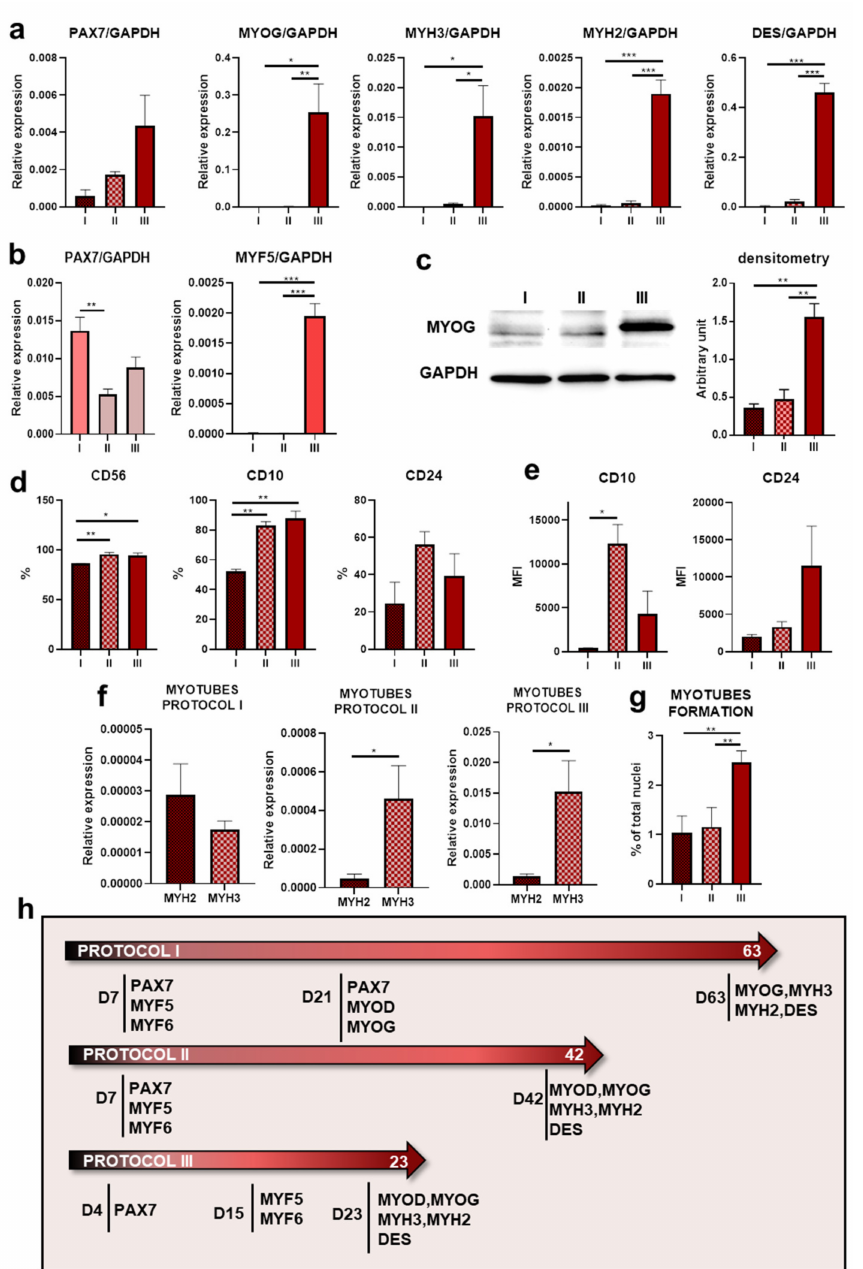
Figure 5. Comparison of protocols of differentiation into skeletal muscles: ( a ) evaluation of transcript levels with qPCR of PAX7 , MYOG , MYH2 , MYH3 , and DES and genes at the termination of differ- entiation in all tested protocols, n : I = 2, II = 4 or 3, III = 4 or 3, * p < 0.05, ** p < 0.01, *** p < 0.0001; ( b ) qPCR evaluation of relative expression of PAX7 and MYF5 at their peaks in different protocols, n : I = 2, II = 4 or 3, III = 4 or 3, ** p < 0.01, *** p < 0.0001; ( c ) MYOG expression analysis on protein levels, representative result of Western blot at the termination of differentiation in all tested protocols with densitometry analysis, n : I = 2, II = 3, III = 3, ** p < 0.01; ( d ) differences in CD56 + , total CD10 + , and total CD24 + expression at the end of the experiment, n : I = 2, II = 5 or 3, III = 3, * p < 0.05, ** p < 0.01; ( e ) MFI analysis of total CD10 + and total CD24 + cells at the termination of differentiation in all tested protocols, n : I =2, II = 3, III = 3, * p < 0.05; ( f ) analysis of relative expression of MYH2 and MYH3 mRNA at the end day of a particular protocol, n : I = 2, II = 4 or 3, III = 4 or 3, * p < 0.05; ( g ) myotube formation represents a percent of multinucleated cells of the total nuclei; n : I = 2, II = 3, III = 3, ** p < 0.01; ( h ) schematic representation of gene expression profiles during